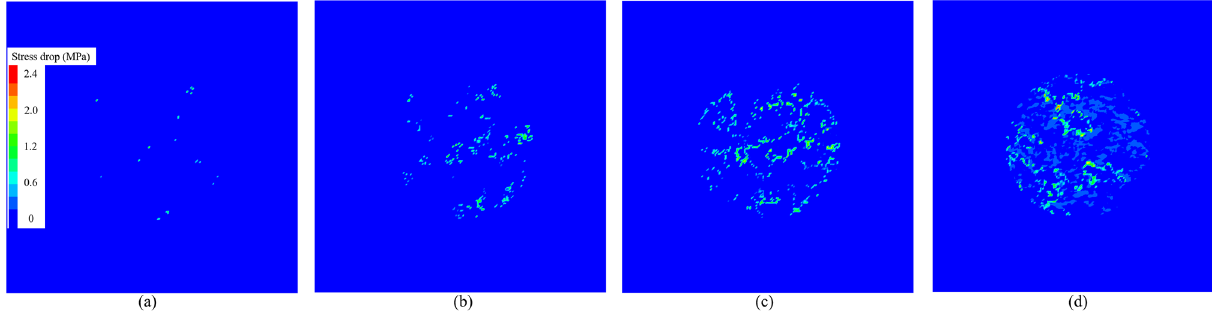
Fig. 17 Shear stress drop on the fault plane during each stage (not cumulative): a 10th stage b 15th stage c 20th stage d 25th